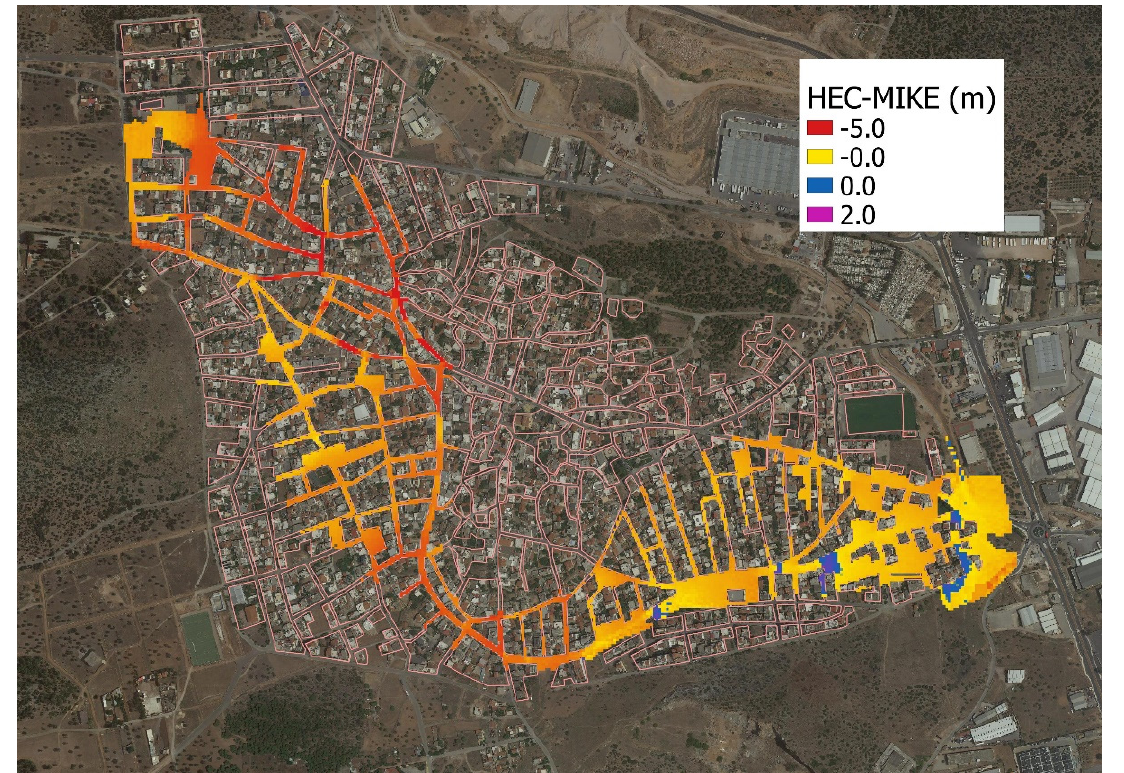
Figure 15. Calibrated HEC-RAS minus informed MIKE FLOOD for maximum water depths.